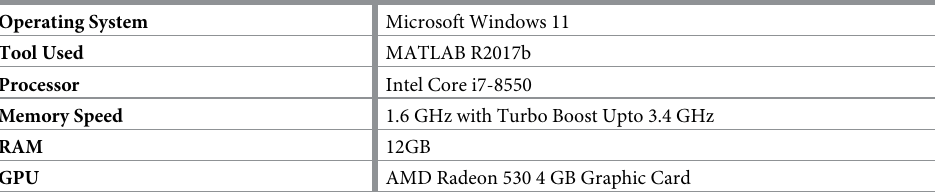
Table 3. Environmental